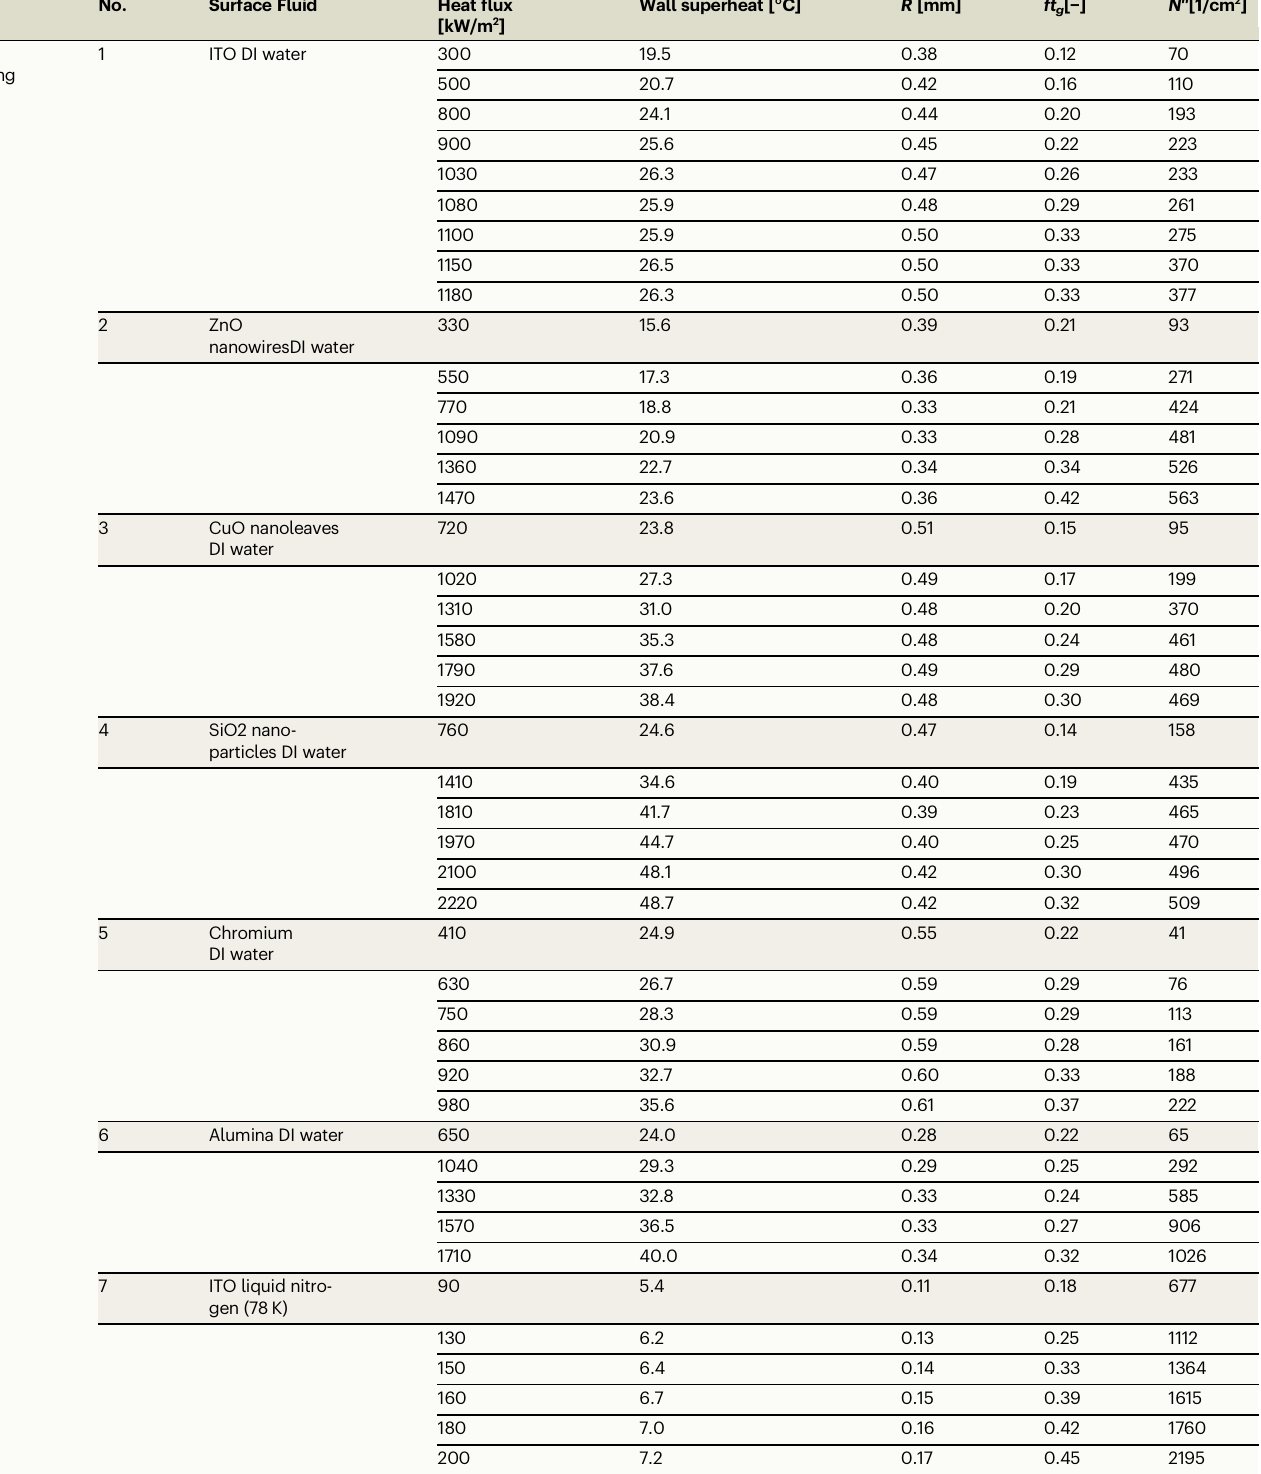
Table 1 | Data of heat fl ux, wall superheat, average bubble footprint radius, R , product of bubble growth time and departure frequency, ft , and nucleation site density, N 00 , for all surfaces and operating conditions tested in pool boiling g